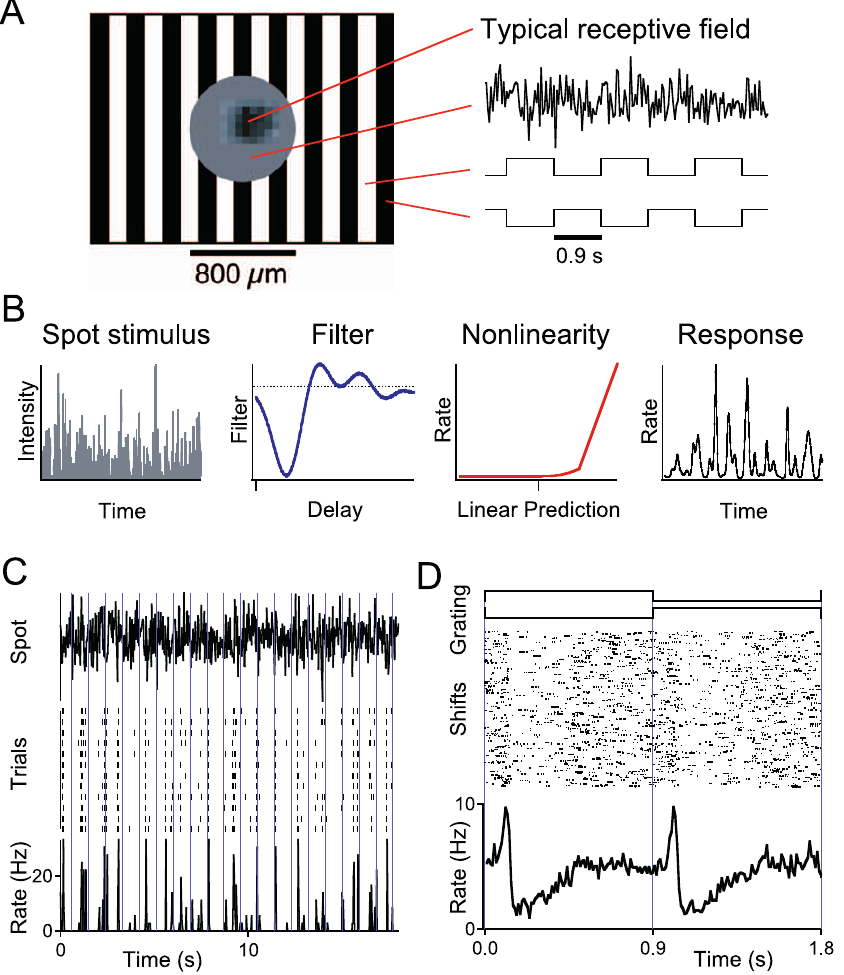
Figure 1. Stimulus, Response, and LN Model (A) Snapshot of the stimulus. A spot covers the center of the display, and a striped grating covers the rest. The receptive field center of a typical ganglion cell is drawn inside the spot. The spot flickers with a pseudo-random intensity (drawn from a Gaussian distribution every 30 ms) while the grating shifts by one bar width every 0.9 s. (B) LN model for the ganglion cell response to the flicker stimulus. The stimulus intensity waveform is convolved with a filter function, and the result is transformed by a static nonlinearity to yield the model’s predicted firing rate. The filter and the nonlinearity are adjusted for the best fit to the cell’s measured firing rate. (C) Responses of a sample ganglion cell. Top: time course of center spot flicker stimulus. Middle: raster plot of spikes on 12 trials with the identical flicker sequence. Vertical lines indicate times of the peripheral grating shift. Note that the cell’s spikes are time-locked to the center stimulus. Bottom: firing rate averaged over the 12 trials. (D) Responses aligned to the grating shifts. Top: time course of grating stimulus, as indicated in (A). Middle: raster plot of spikes for 300 grating shift periods; each period includes two shifts of the grating by one bar width. The center stimulus followed a different random sequence in each shift period, which accounts for the variability in spike timing (see [C]). Bottom: firing rate averaged over 8,221 shift